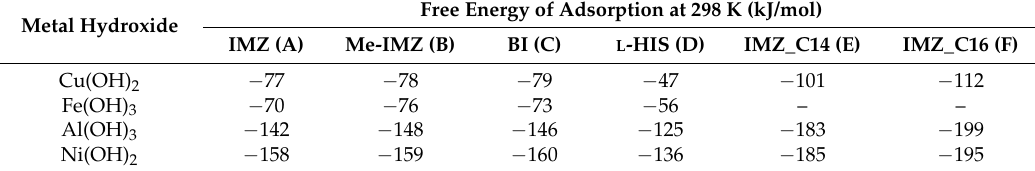
Table 5. Free Energy of adsorption (kJ/mol) of different corrosion inhibitors on to various metal hydroxide substrates at 298 K in presence of water. Binding Energies from Table 2 and log P values with reference to hexane from Table 3 are